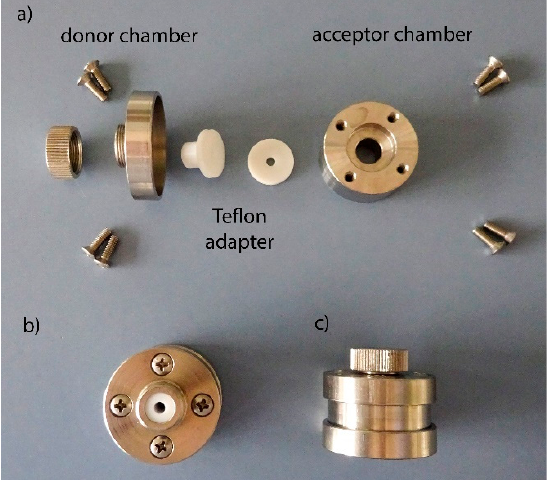
Figure 1 . Two-chamber permeation device. Individual components ( a ), assembled permeation Figure 1. Two‑chamber permeation device. Individual components ( a ), assembled permeation gad‑ gadget top view with Teflon adapter ( b ), closed permeation device ( c ). get top view with Teflon adapter ( b ), closed permeation device ( c